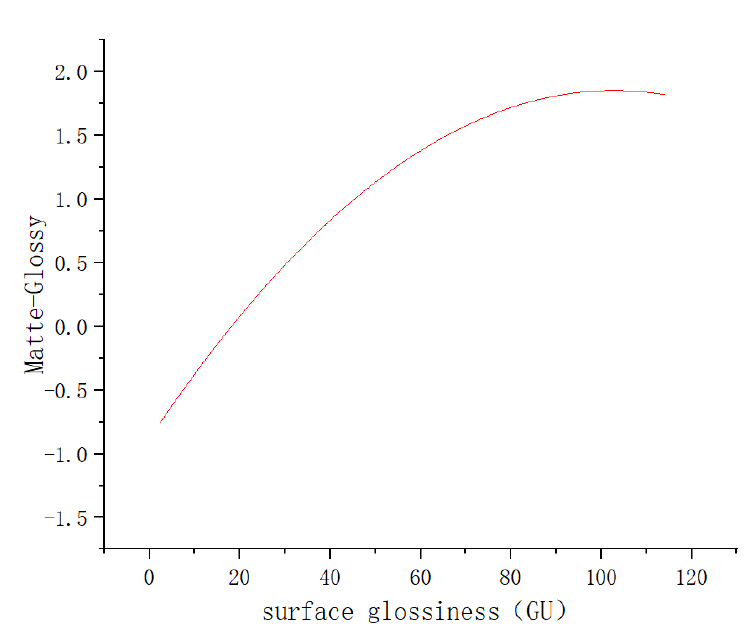
Figure 16. “Matte-Glossy” and surface gloss polynomial fitting function.